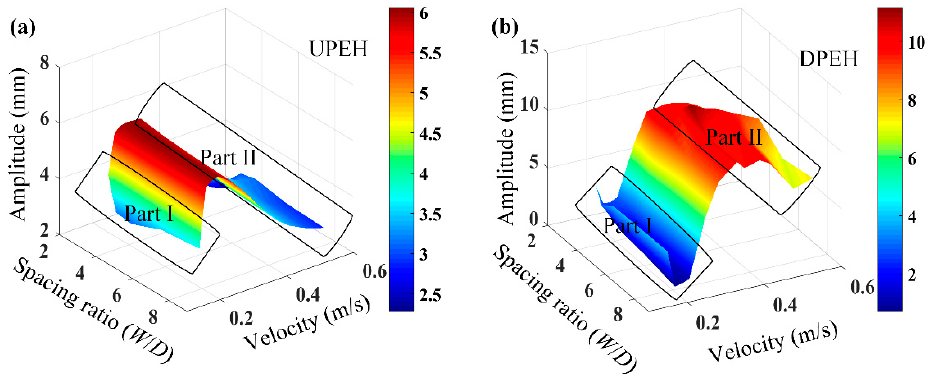
Figure 8. Comparison of vibration amplitudes of the upstream and downstream PEH: ( a ) UPEH, ( b ) DPEH.